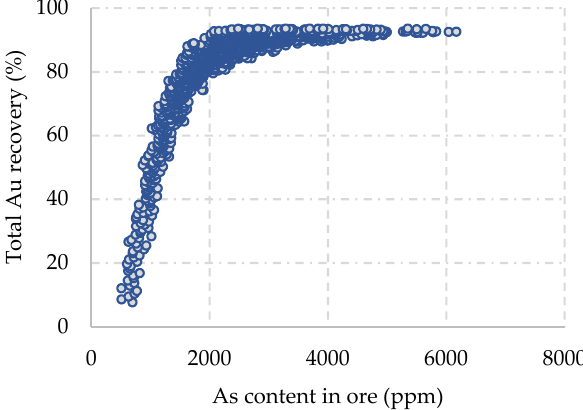
Figure 6. Scatterplot of arsenic content and total gold recovery.